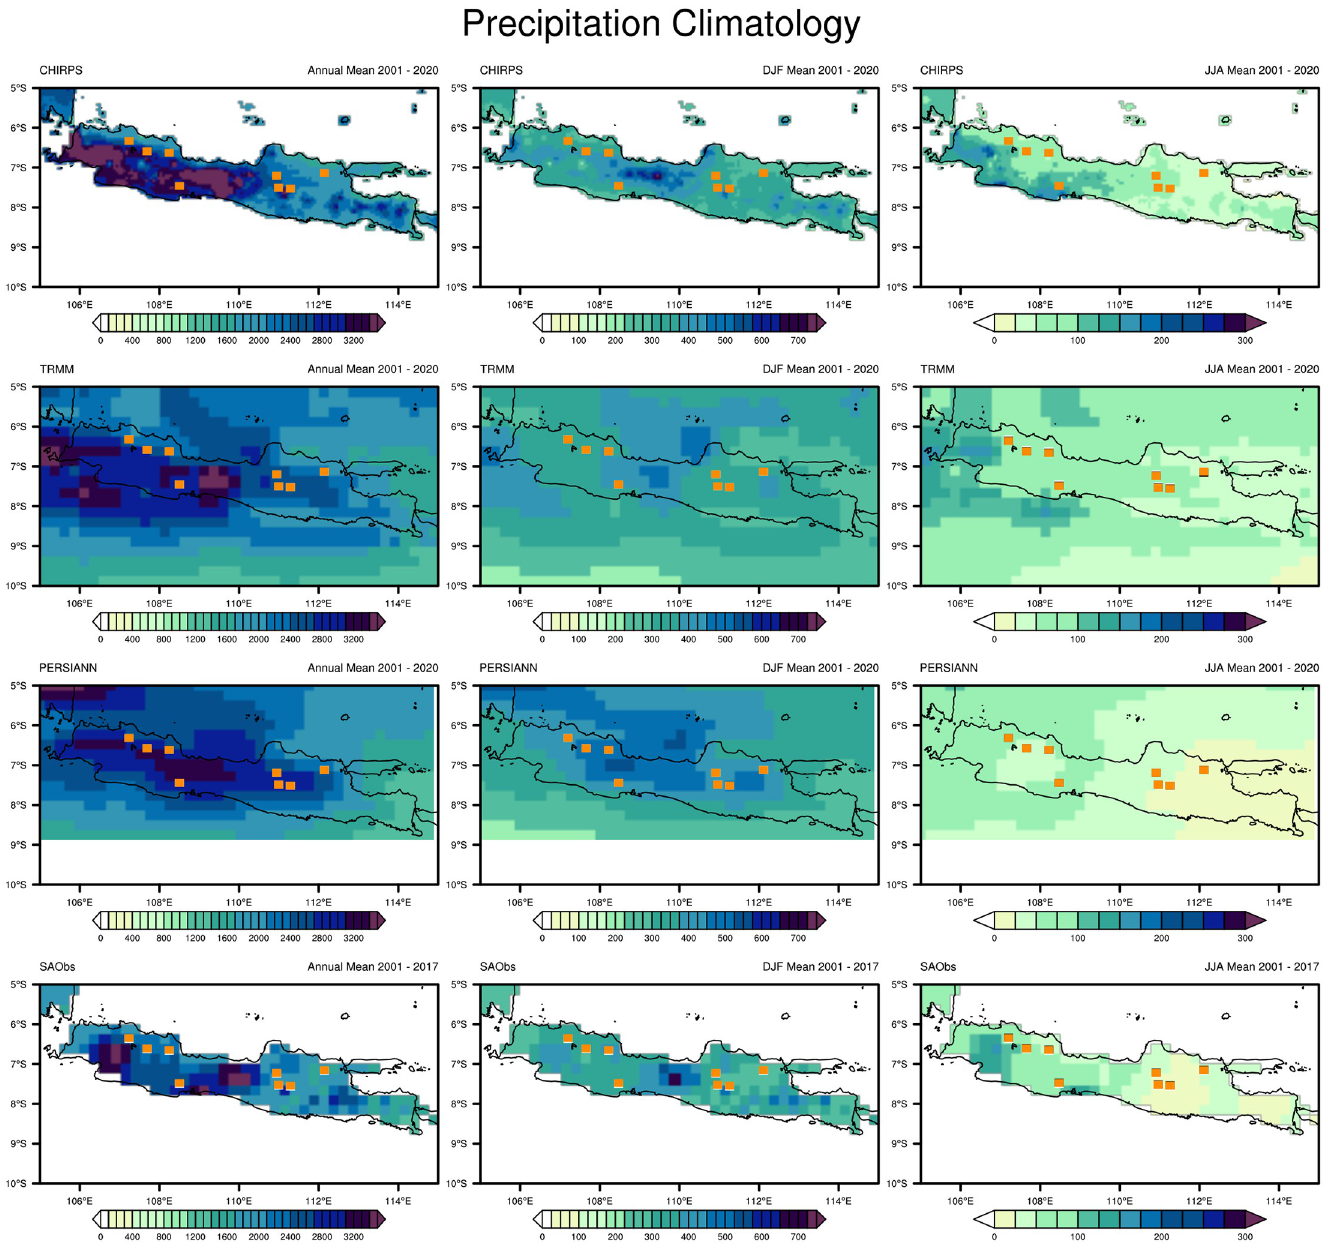
Fig 2. Comparison of the annual total precipitation (left), mean monthly precipitation in the rainy season (middle), and mean monthly precipitation in the dry season (right) over the study area according to 20 years of climatological data from CHIRPS, TRMM, PERSIANN, and SA-OBS. The rainy season corresponds to December, January, and February (DJF); the dry season corresponds to June, July, and August (JJA). Dots on the map indicate the largest rice-producing districts of